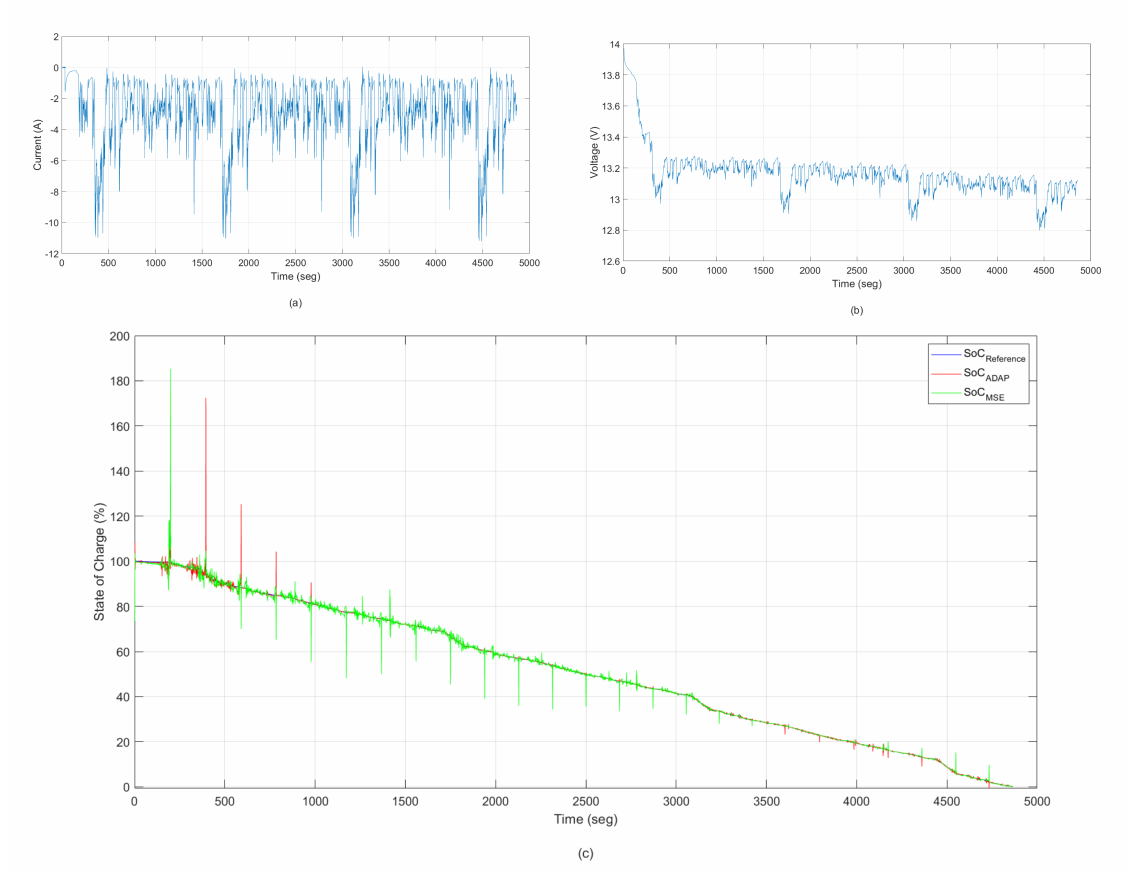
Figure 13. Validation of ANN models. State of Charge—training result without the presence of noise and outliers—The Urban Dynamometer Driving Schedule: ( a ) current; ( b ) voltage for the UDDS cycle and ( c ) state of charge (SoC)